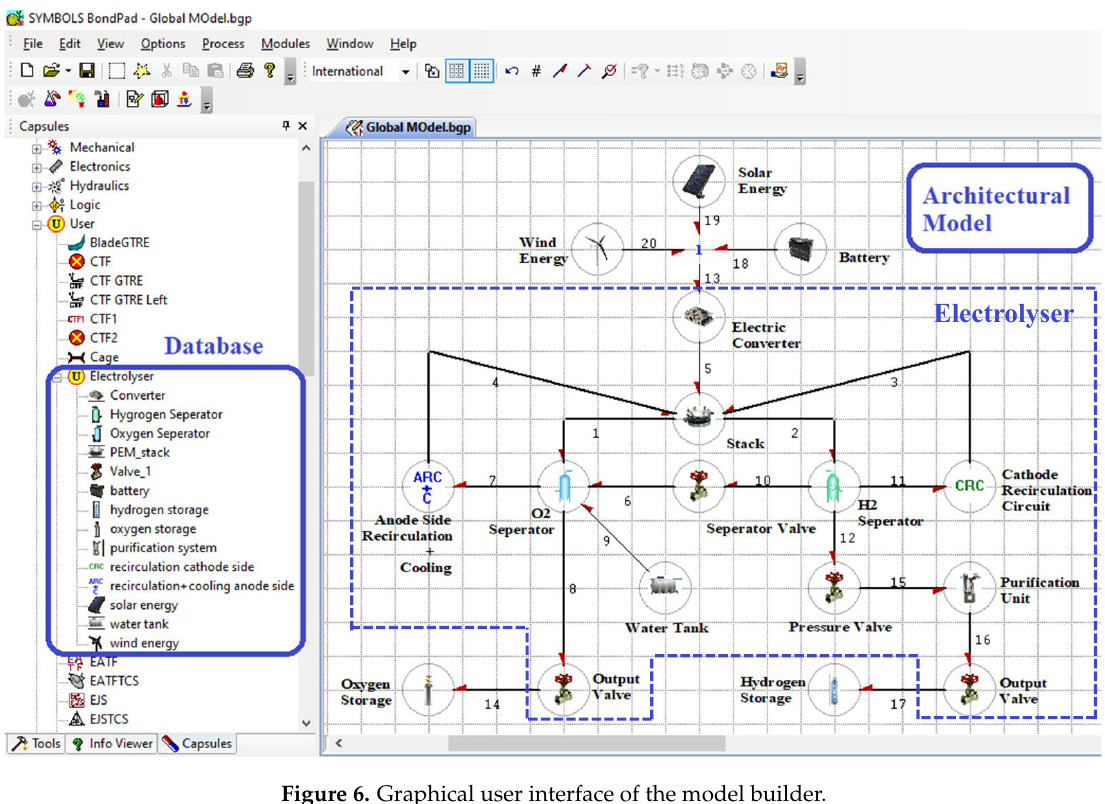
Figure 6. Graphical user interface of the model builder.